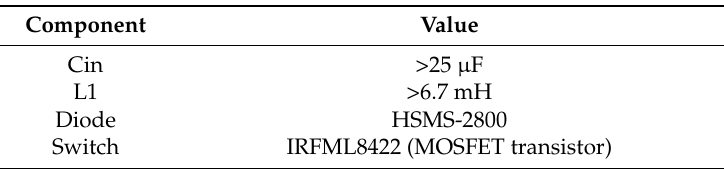
Figure 9. Boost DC-DC circuit. In red, a dual solar panel MPPT control block diagram. Table 3. Component values for the DC-DC boost converter.